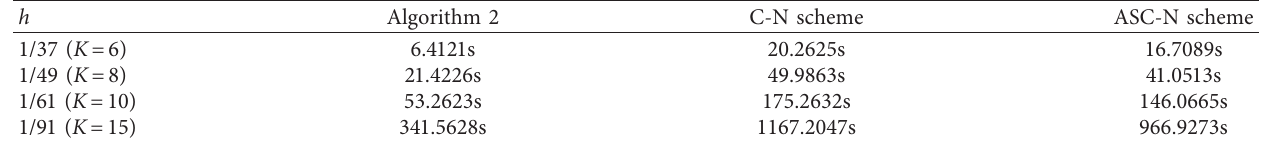
Table 8: Comparison of three schemes’ calculation time for r � 1.2 at t �